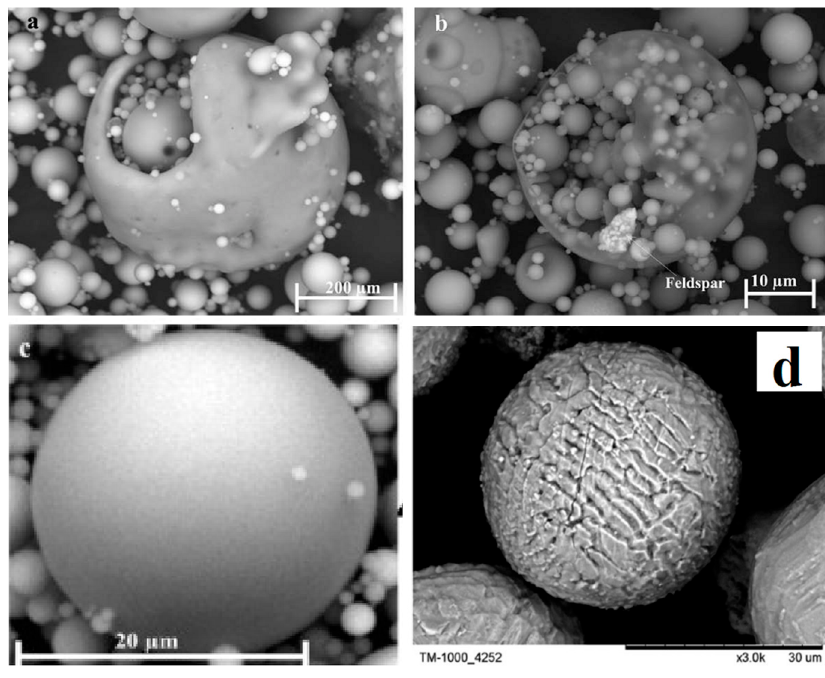
Figure 1. SEM micrograph of fly ash, plerospheres ( a , b ) cenospheres ( c ) ferrospheres ( d ) adapted from Goodzari and Sanei [40] and Olga Sharonova et al. [40].